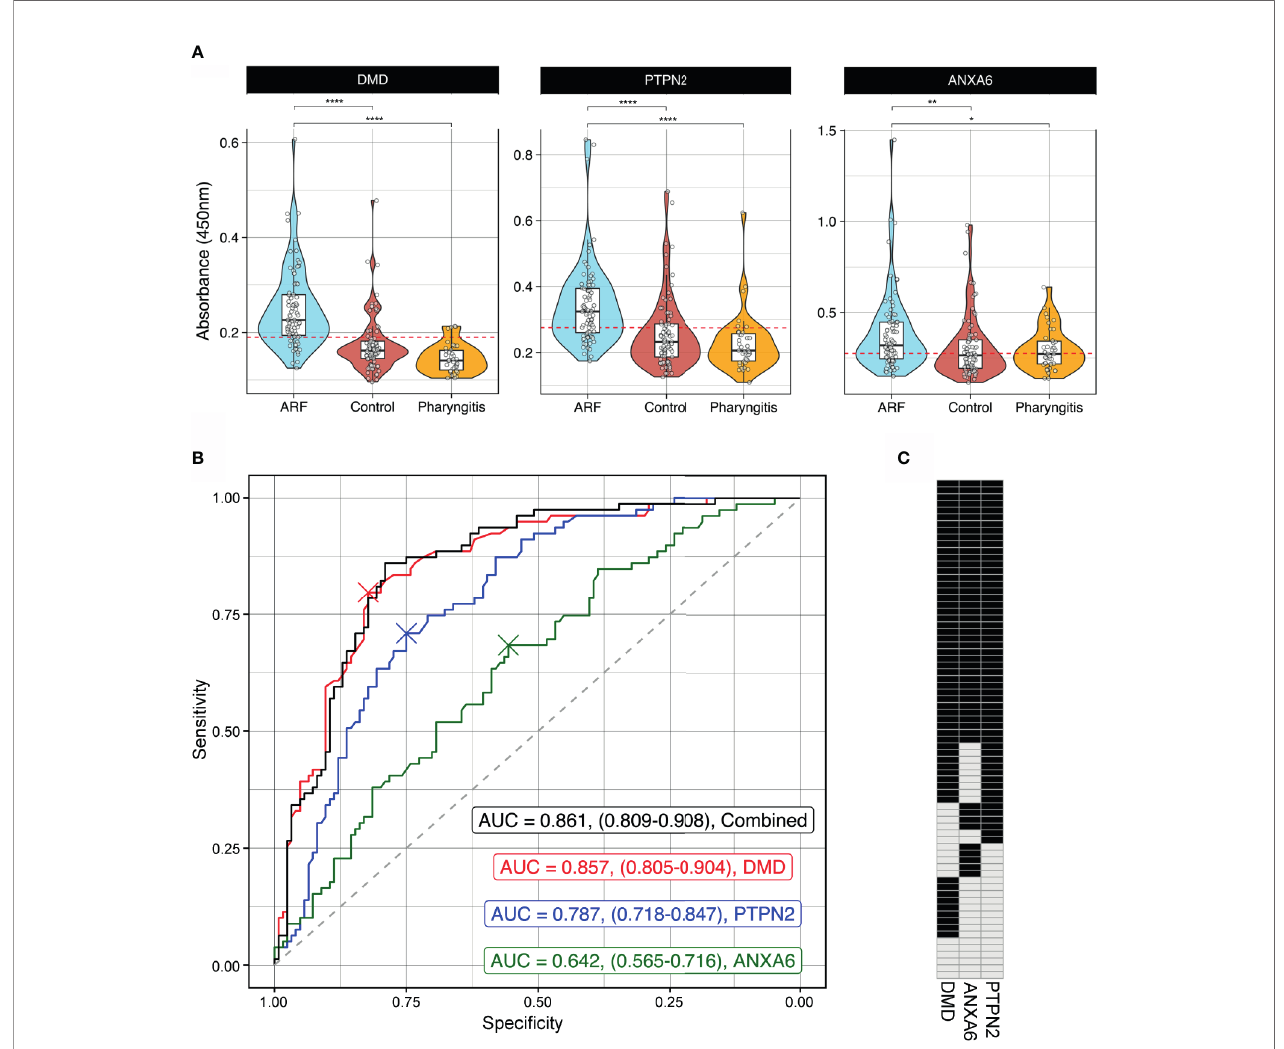
FIGURE 4 | Orthogonal validation of autoantigens by ELISA (A) Combined violin and box and whisker plots showing ELISAs targeting DMD (left), PTPN2 (middle) and ANXA6 (right) using sera from ARF patients (blue, n=79), matched healthy controls (red, n=85) and children with GAS positive pharyngitis (orange, n=39). For box and whisker plots the lower and upper hinges correspond to the fi rst and third quartiles (the 25th and 75th percentiles). The whiskers extend from the hinge to the largest and smallest value no further than 1.5 x inter-quartile range from the respective hinge. The violin plot extends from the highest to the lowest value showing density of data. Red dashed line represents the cut-off for positivity positive based analysis in part (B). *p < 0.05, **p < 0.01, ****< 0.0001 using two sample Wilcoxon test. (B) Receiver Operator Curves (ROC) of ELISA results from DMD (red), PTPN2 (blue) and ANXA6 (green) as well as all three antigens combined (black). Grey dashed line represents the line of no discrimination, which would indicate a test with no predictive power. The AUC for each analysis is indicated with con fi dence intervals obtained using bootstrapping in brackets. The crosses represent the optimal cut-off for each autoantigen ELISA. (C) Barcode of all 79 ARF patients indicating positive (black) or negative (grey) reactivity to all three autoantigens. Cut-off for positivity was determined from the ROC analysis in part (B) and is represented visually as a red dashed line in part